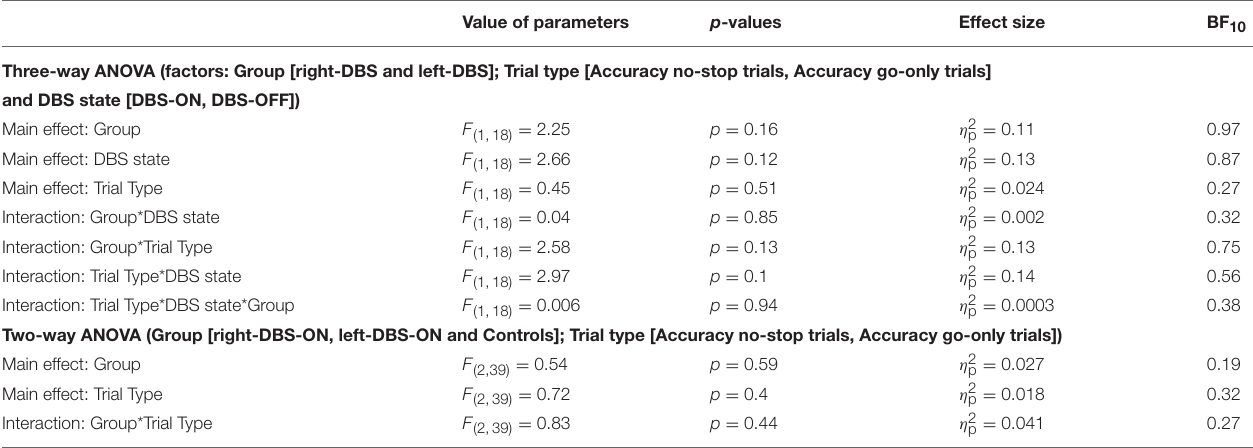
TABLE 6 | Results of the statistical analysis of the accuracy for right-DBS patients, left-DBS patients, and age-matched controls. Value of parameters p -values Effect size BF